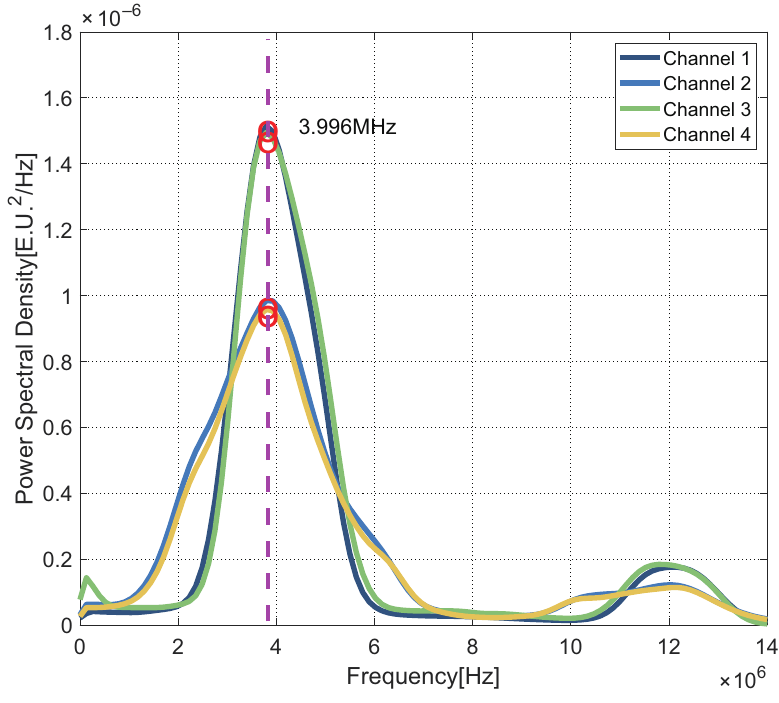
Figure 11. Power spectral densities of the signals at the four channels of